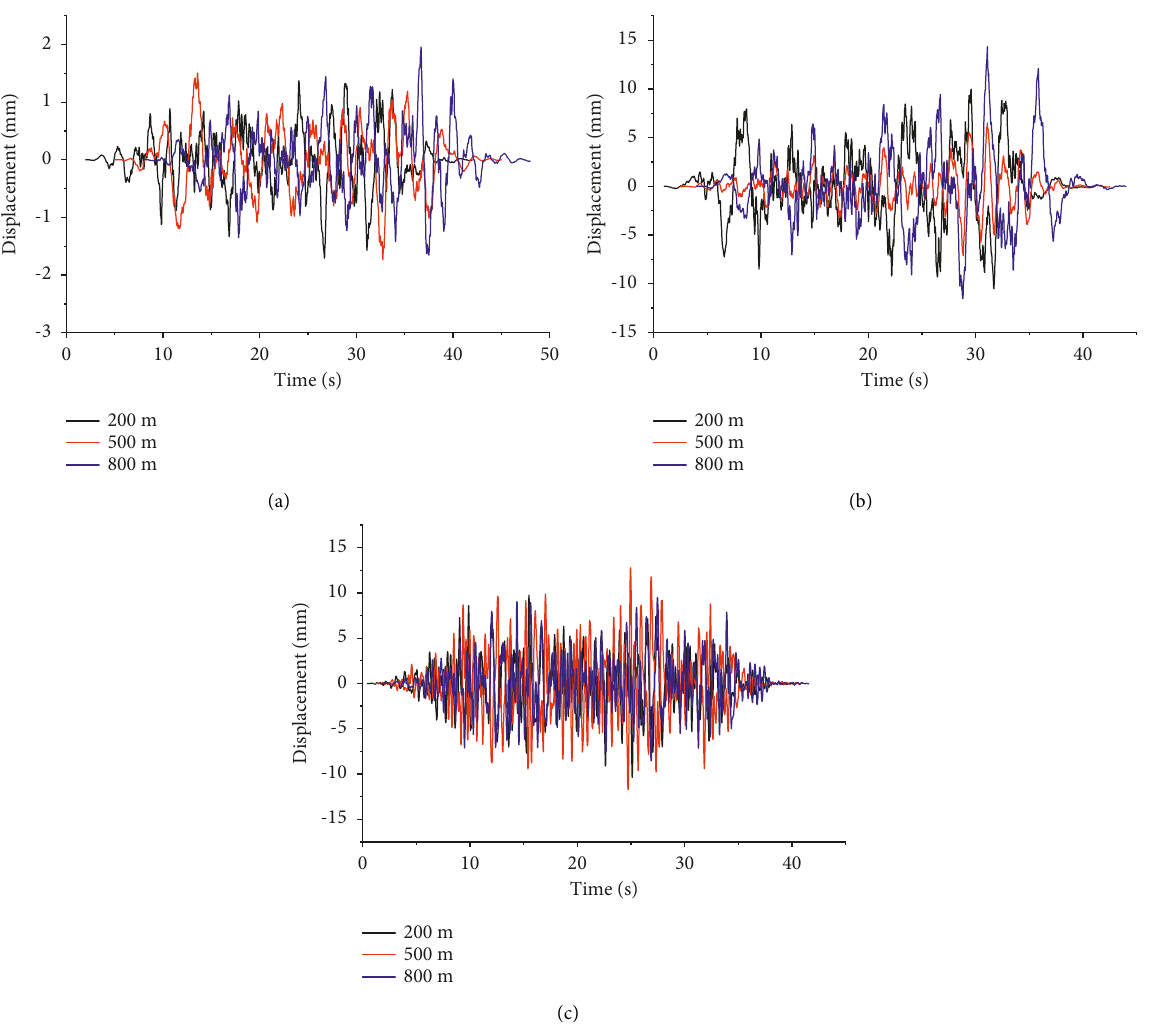
Figure 6: Longitudinal vibration displacement time course curves of pipes at different positions. (a) Wave speed v � 100m/s (normal). (b) Wave speed v � 200m/s (vacant). (c) Wave speed v � 500m/s (polymer grouting